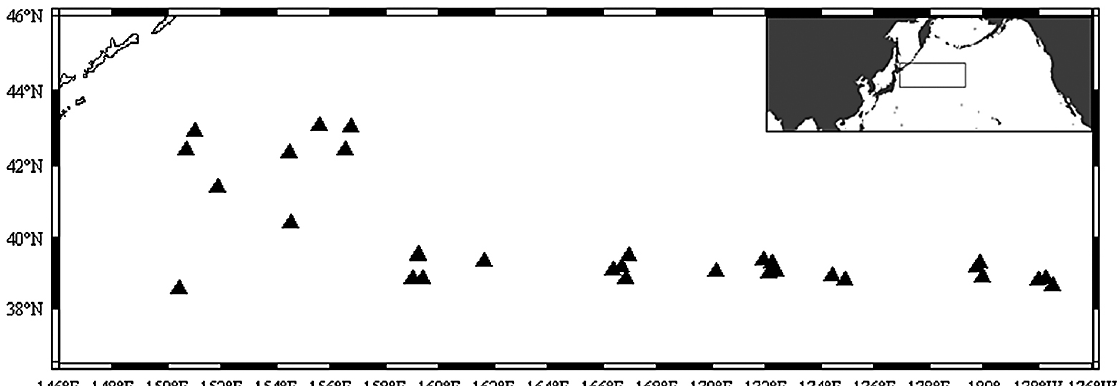
Fig. 1. – Distribution of sampling station of O . bartramii in North Pacific Ocean.